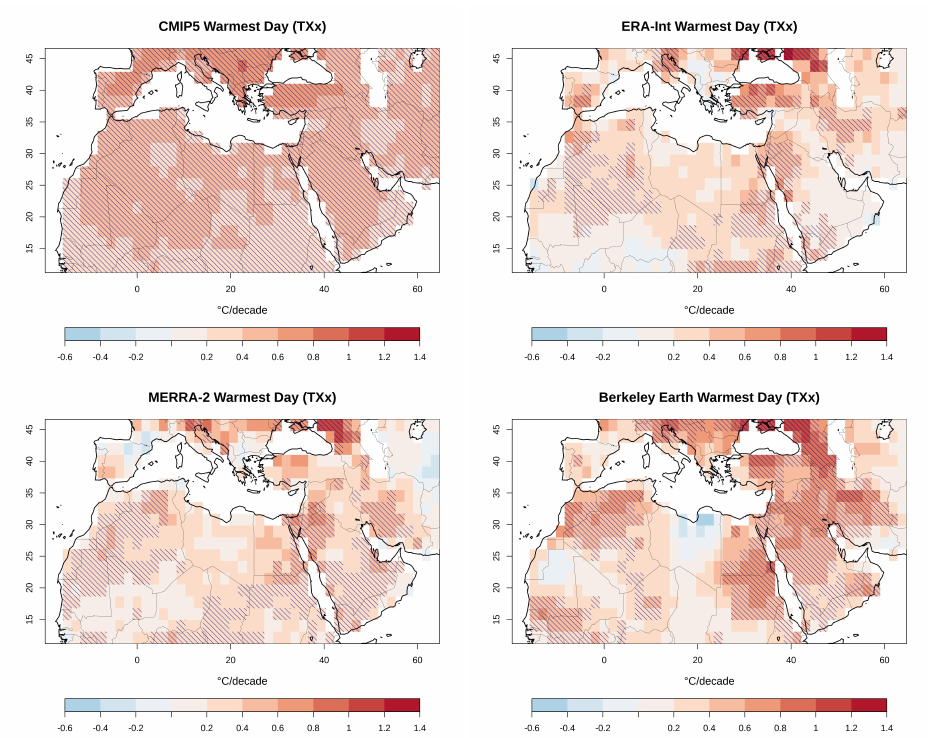
Figure 5. 1980–2018 decadal trend of the Warmest Day (TXx) for the: CMIP5 multi-model ensemble mean ( top left ), ERA-Interim ( top right ), MERRA-2 ( bottom left ), and Berkeley Earth ( bottom right ). The hatching represents the statistical significance of the trends at 95% confidence.